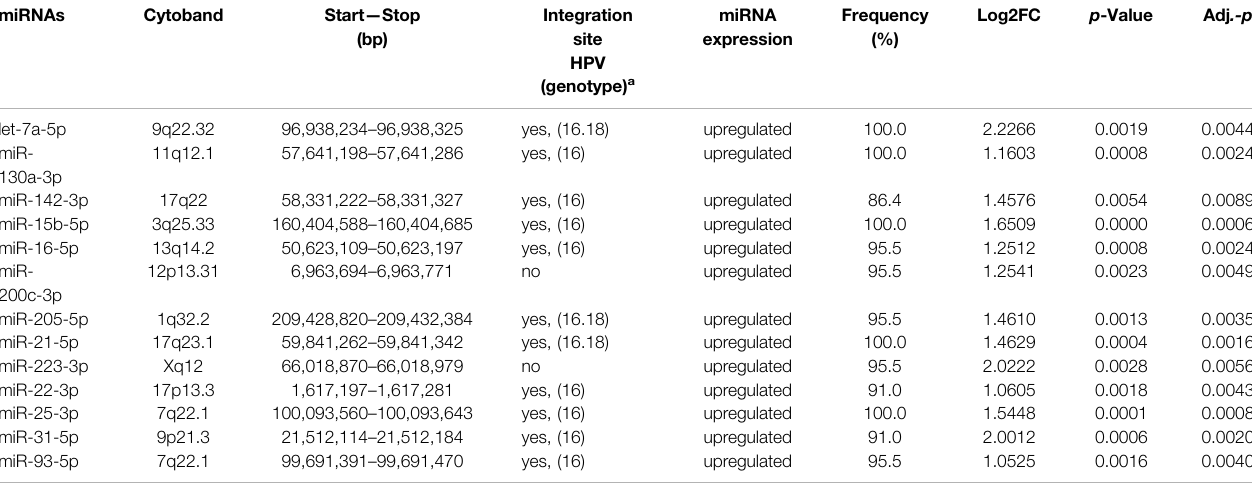
Integration (bp) site